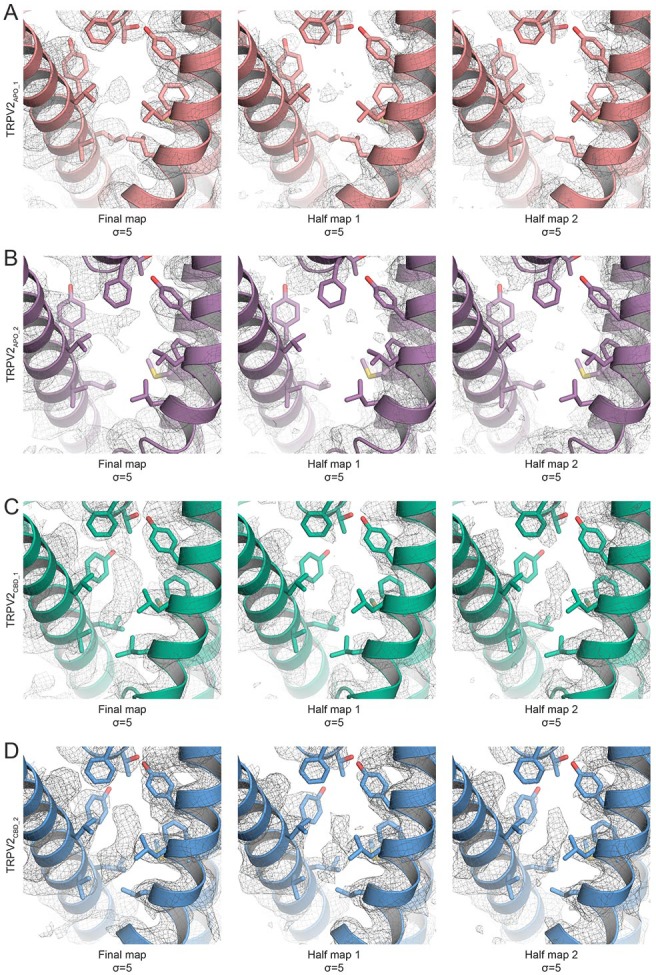
Cryo-EM density in the CBD binding pocket.TRPV2 models overlaid with the final postprocessed map and the two corresponding half maps for (A) TRPV2APO_1, (B) TRPV2APO_2, (C) TRPV2CBD_1, and (D) TRPV2CBD_2. Cryo-EM densities are contoured at σ = 5 and are shown as gray mesh. Side chains of interest are shown as sticks. Bound CBD is not shown.